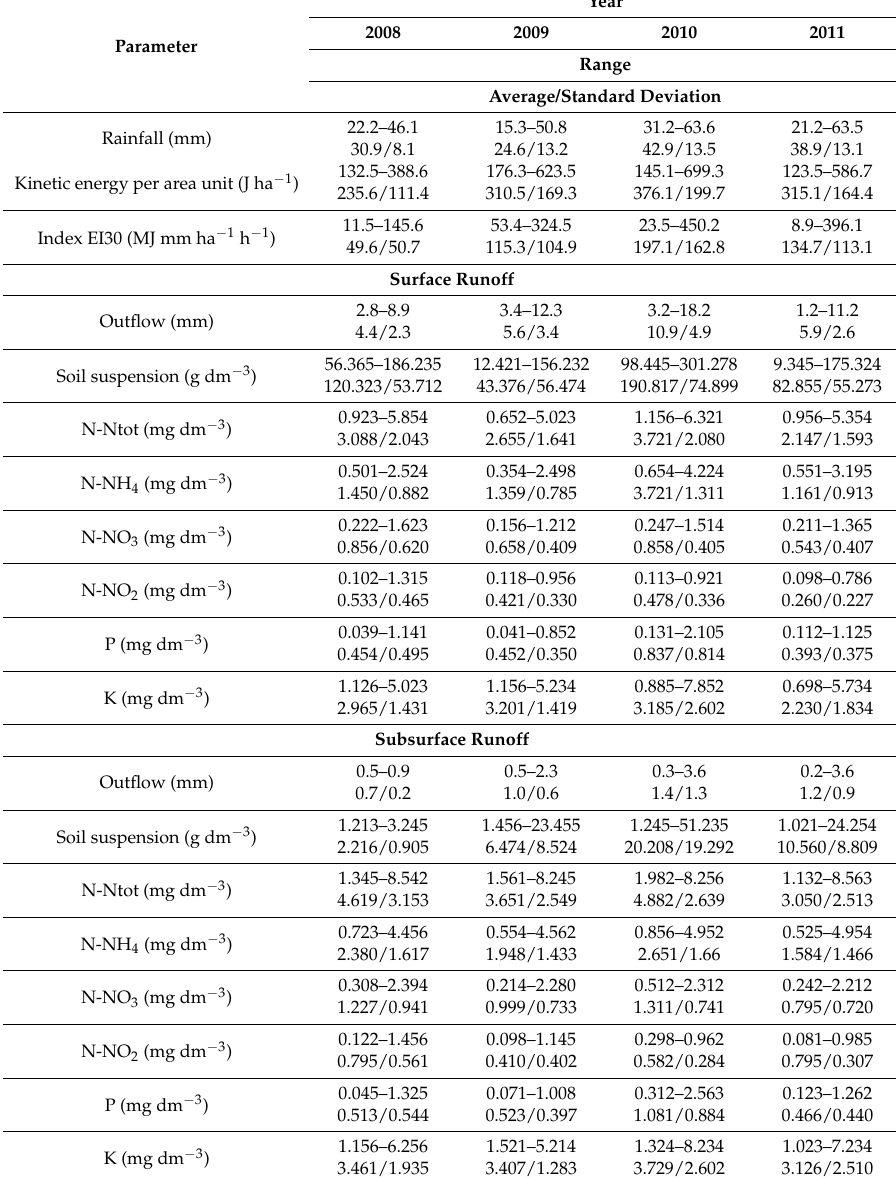
Table 5. Range, average and standard deviation values characterizing the precipitation as well as the quantity and quality of water outflow from the